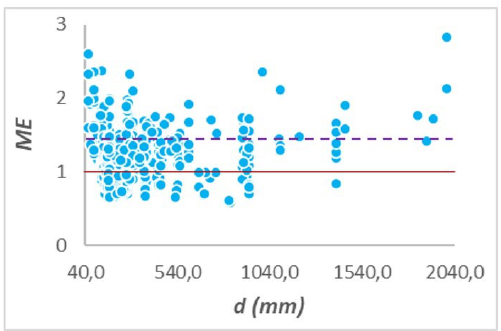
Figure 16- Model Error (ME) to the proposed